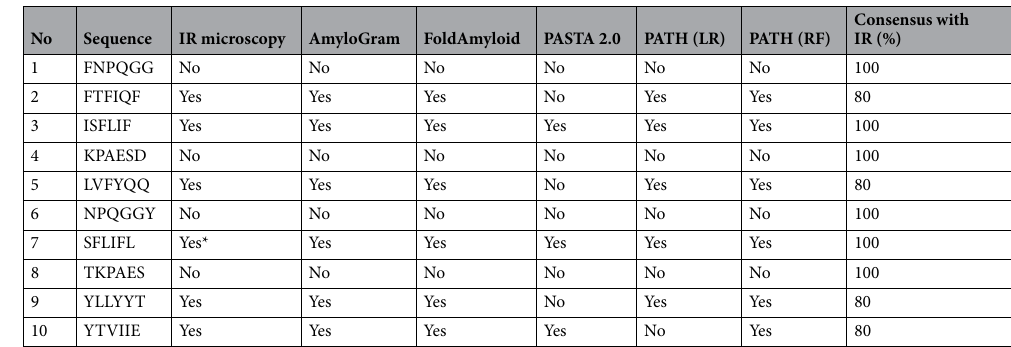
Table 2. Reference sequences and their amyloid propensity obtained by different bioinformatic methods, compared to IR microscopy (’Yes’—amyloid, ’No’—non-amyloid,